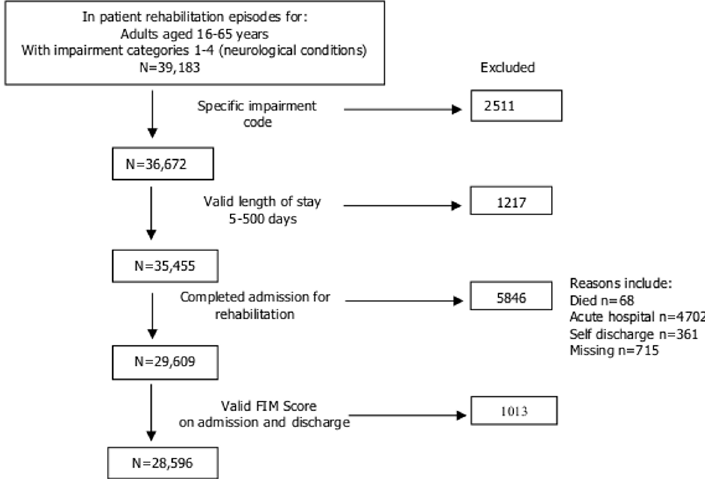
Fig 1. Flow chart — data exclusion. The figure shows the different stages of the data cleaning process to obtain a dataset comprising completed episodes of rehabilitation with valid FIM scores. The most common reason for exclusion, accounting for more than half the excluded cases, was transfer back to the acute hospital setting for medical or surgical management. Many such cases will have returned to rehabilitation in a separate episode. Multiple episodes for the same individual were not linked in this analysis, but the process of concatenation will support linkage of serial episodes in future